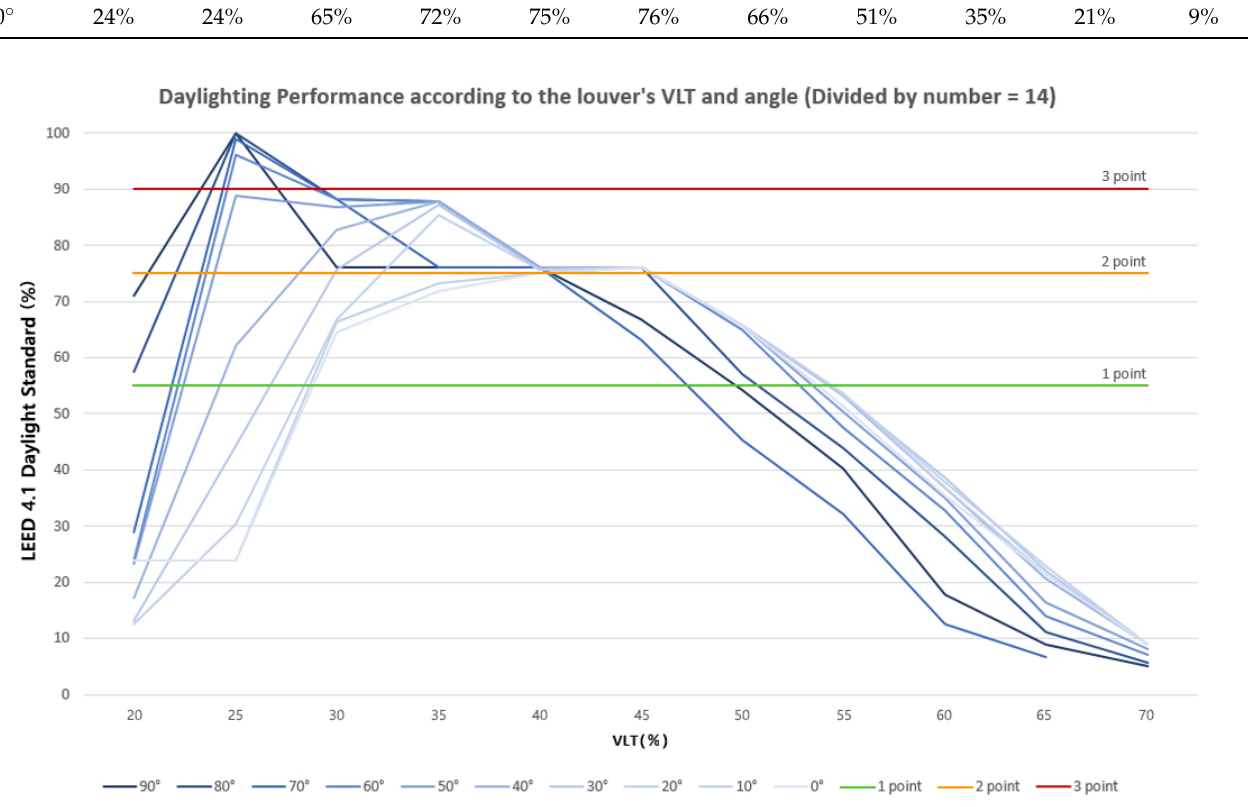
Figure 9. Target illuminance achievement rate graph when the number of divisions of louvers is 14. Table 9 and Figure 10 show target illuminance achievement rates when the number of divisions of louvers is 15. As with the previous results, there were a total of four cases where three points could be obtained. There were 37 cases in which two points could be obtained. The total number of cases in which two or more points could be obtained was